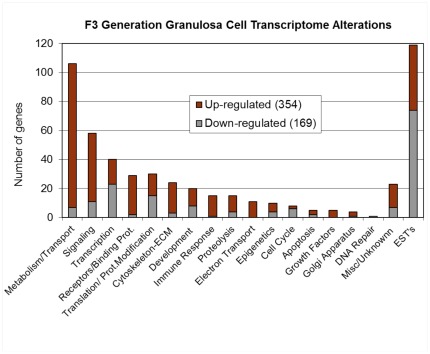
Number of genes with mRNA expression levels significantly different between Control and Vinclozolin-lineage F3 generation granulosa cells.Genes are placed into functional categories.